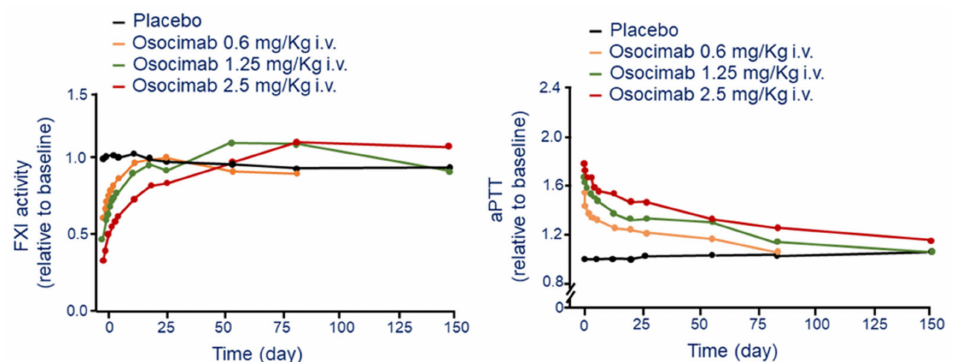
Figure 2. Time and dose-dependent effect of osocimab on FXI activity ( left panel ) and aPTT ( right panel ) following a single i.v. administration. Modified from Thomas D et al. [24]. F: factor; aPTT: activated partial thromboplastin